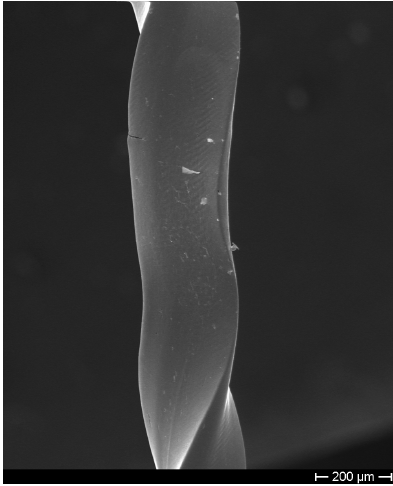
Figure 17: Unwinding failure mechanism on instrument no. 9. Figure 18: Micro cracks on instrument no. 9 surface.